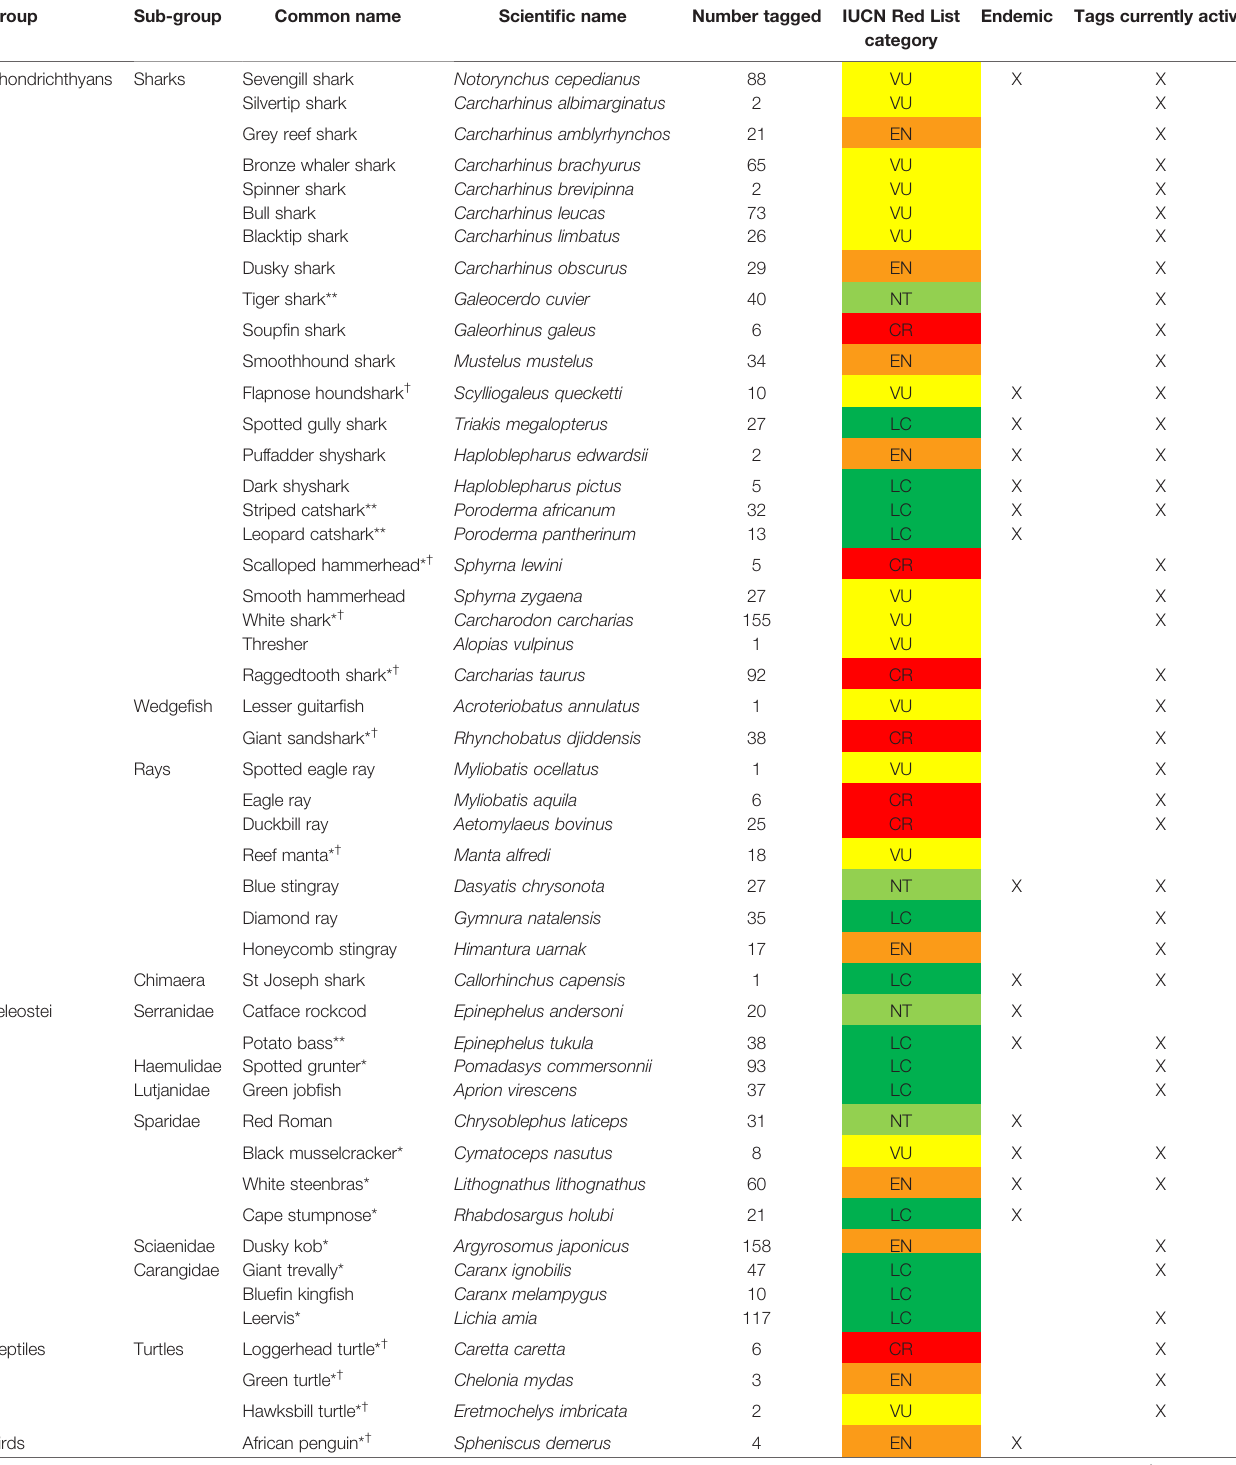
TABLE 1 | List of species which have been tagged by researchers in South Africa and have been, or are currently, monitored by the nationwide Acoustic Tracking Array Platform.